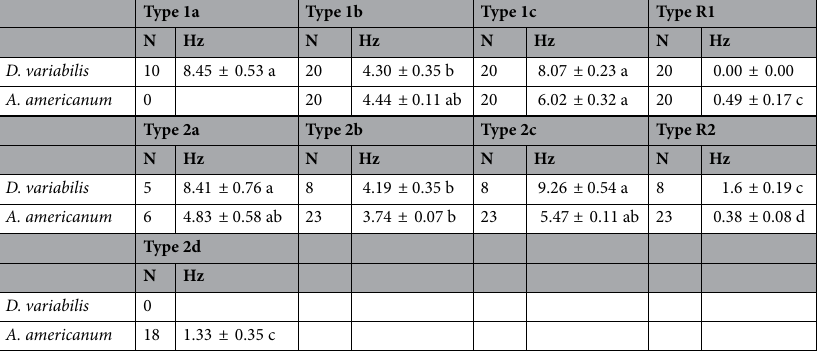
Table 3. Results of frequency analysis of tick waveform types. Mean ± standard errors in Hz. Same lower case letter indicates values were not significantly